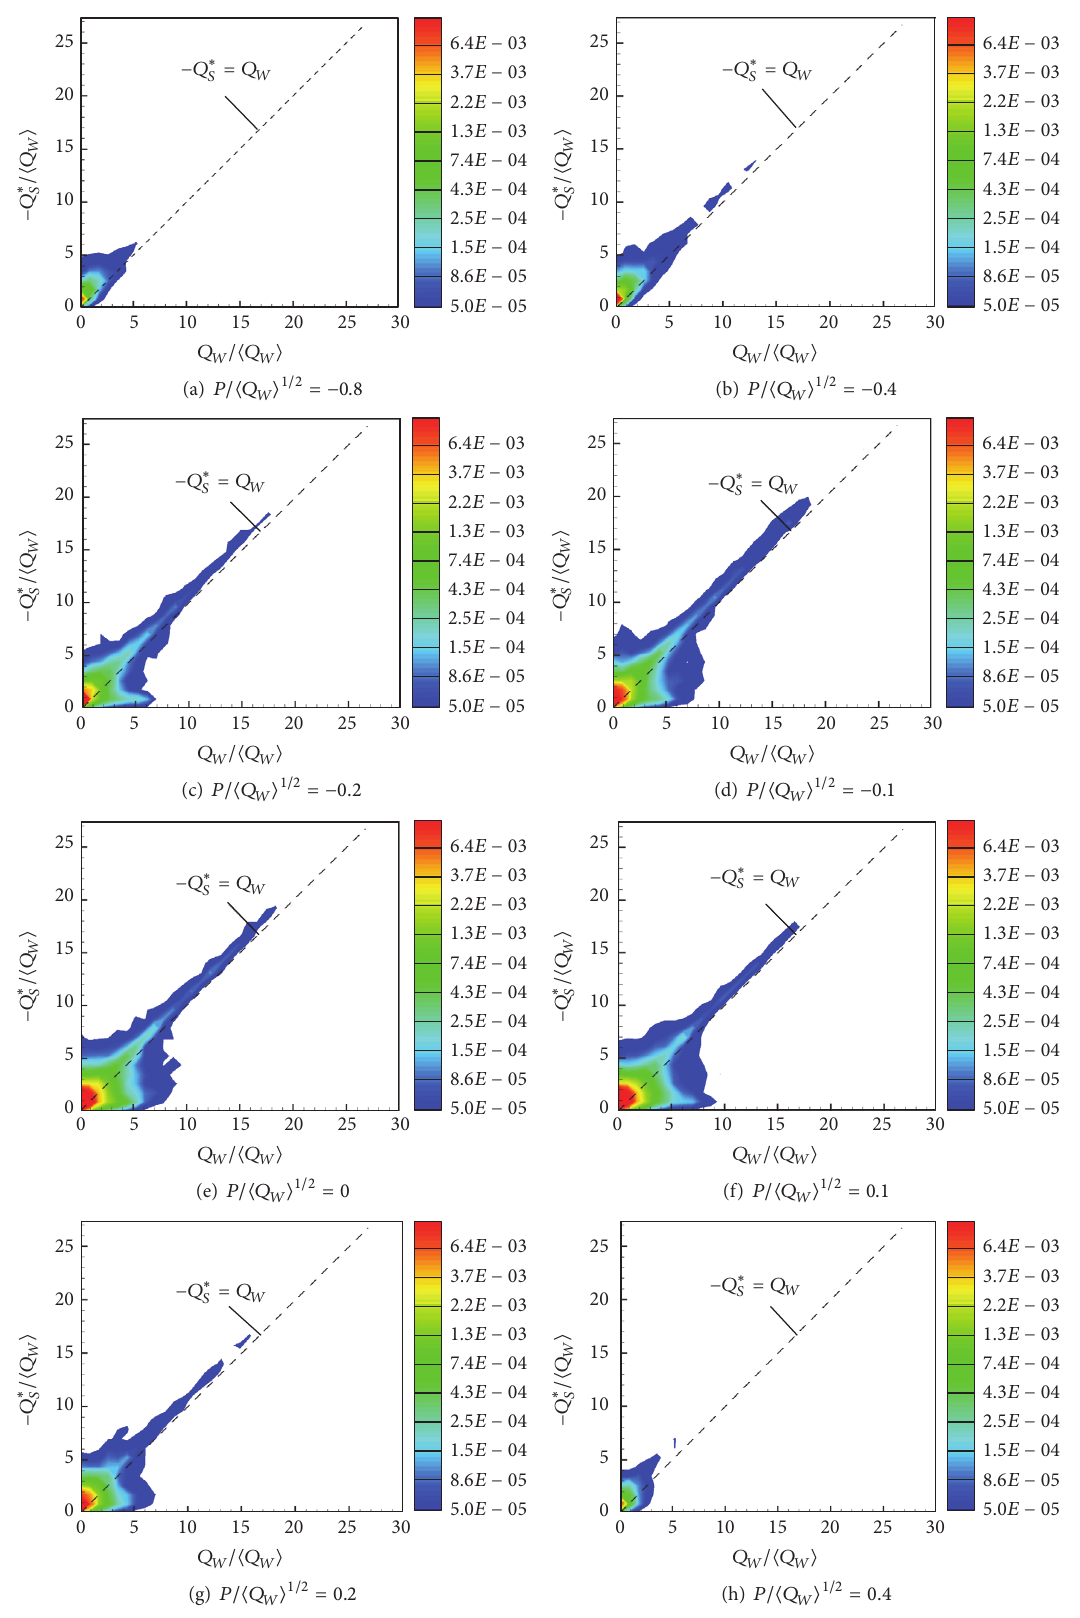
Figure 12: Joint p.d.f. of 𝑄 ∗ 𝑆 - 𝑄 𝑊 invariants in the flame zone at 𝑡 = 501 𝜇